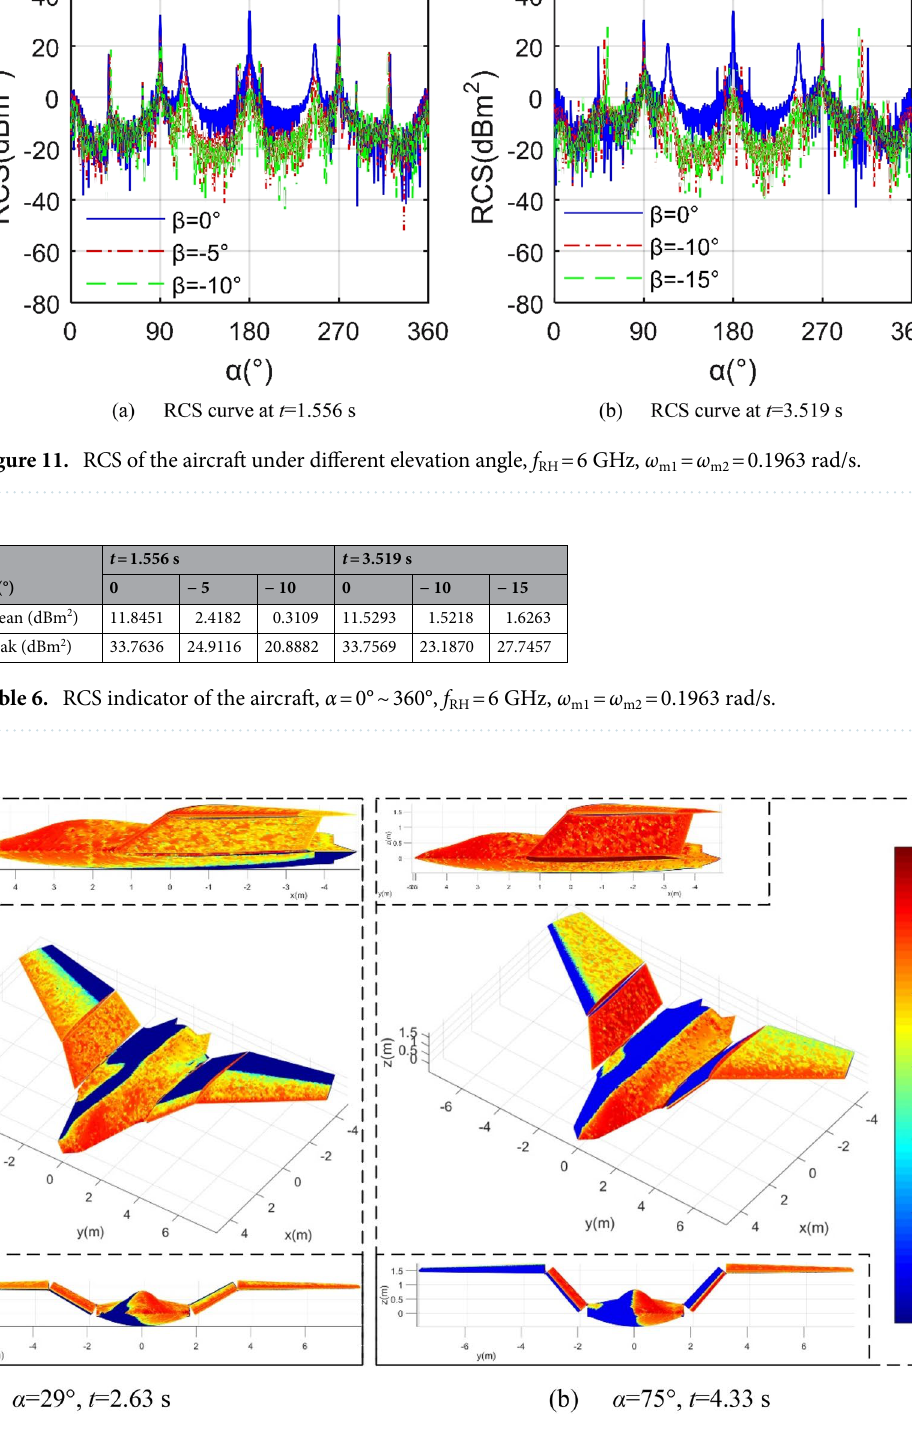
Figure 12. Surface scattering characteristics of aircraft in Z3 mode, β = 5°, f RH = 6 GHz, ω m1 = ω m2 = 0.1963 rad/s, RCS unit: dBm 2